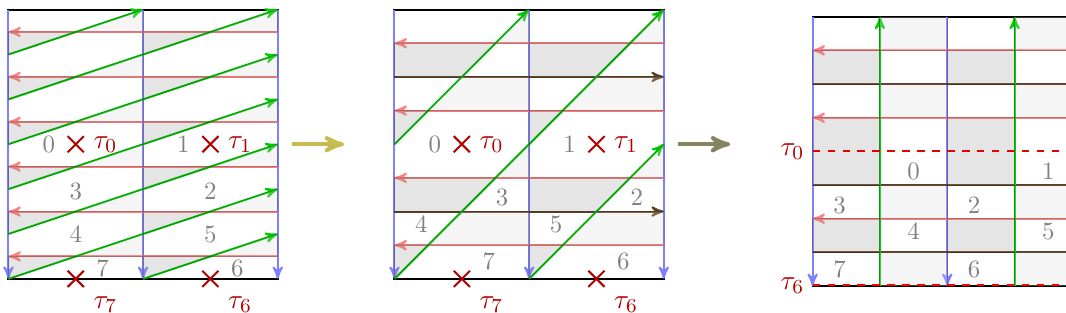
Figure 20. The chain of five-brane diagrams of family B connected by mass deformation for k = 3 : L 0 , 6 , 0 / Z 2 → L 2 , 4 , 2 / Z 2 → L 3 , 3 , 3 / Z 2 . It holds also with the orientifold projection, provided a Z 2 symmetry is preserved.